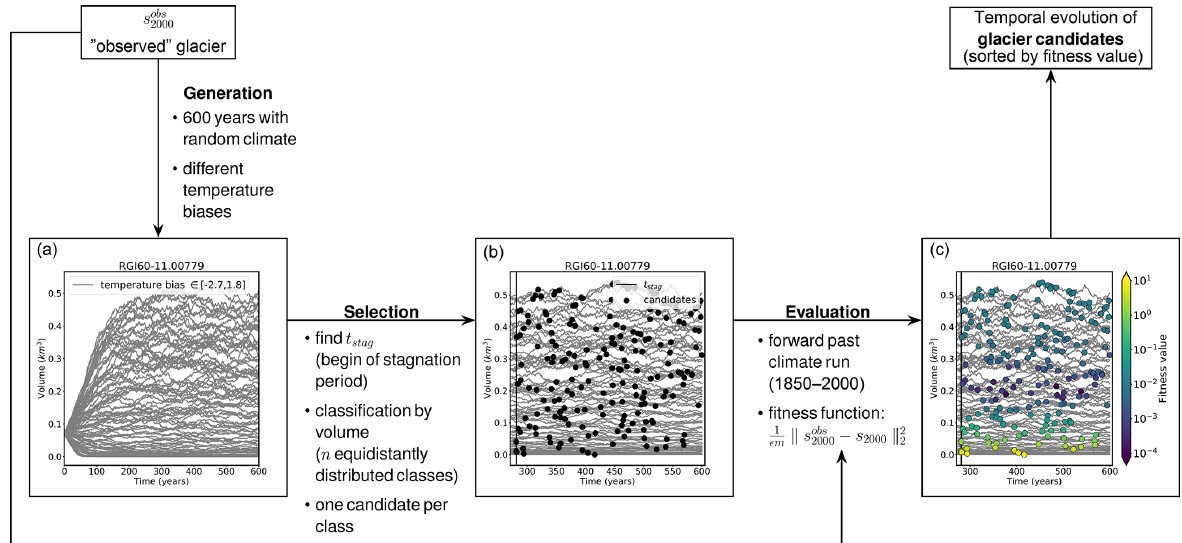
Figure 2. Workflow of the candidate generation, selection, and ranking method, using Guslarferner (Ötztal, Austria) as an example. (a) Gen- eration of potential glacier candidates. The grey lines indicate the glacier volume evolution for a set of different random climate scenarios over 600 years each. The temperature biases vary between − 2 . 7 and 1.8K. (b) Selection of candidates. The black vertical line indicates t stag and the black points show 200 candidates. (c) Glacier candidates colored by their fitness value. Violet marks candidates with a small misfit, whereas yellow marks states that do not meet the acceptance criterion (Eq.